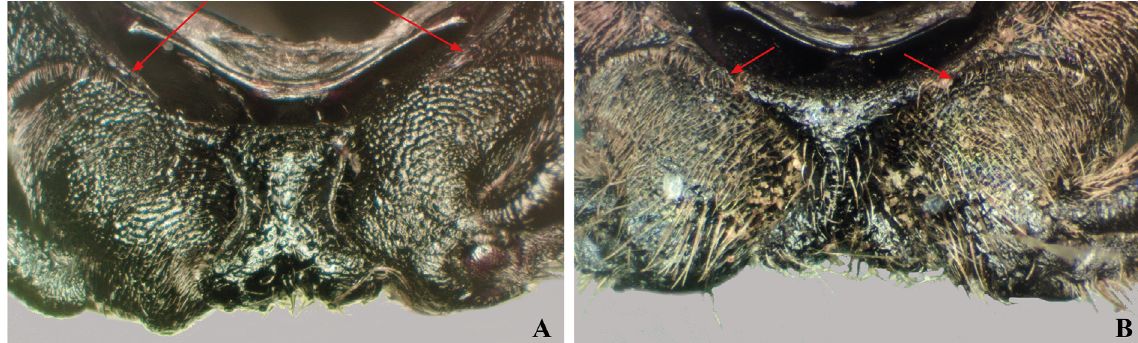
Fig. 25. Closure of procoxal cavities of Platyope Fischer von Waldheim, 1820 and Earophanta Semenov, 1903, posterior view. A . Externally open procoxal cavities of Platyope unicolor Zubkov, 1829 (ZMSFU). B . Externally closed procoxal cavities of Earophanta serrata (Semenov, 1893), ♂ (ZIN). Arrows indicate postcoxal bridge. Not to